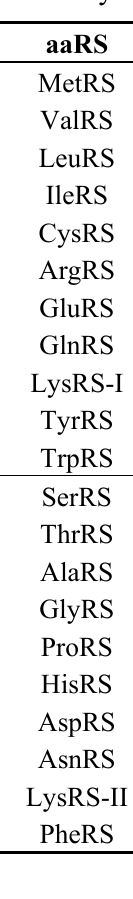
Table 1. Classes of aminoacyl-tRNA